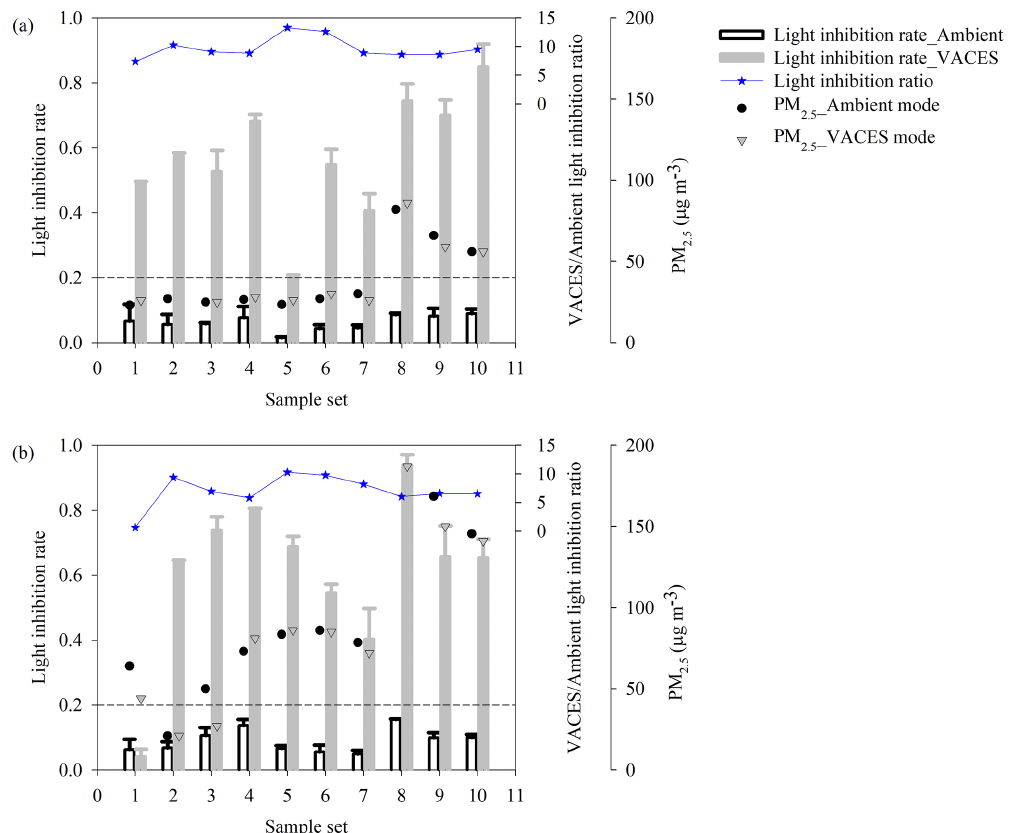
Figure 4. Comparison of light inhibition rate and ratio of ambient and VACES particles with ambient PM 2 . 5 concentration based on (a) hourly and (b) 30min discontinuous sample collection during 23 October–11 December 2019 in Shanghai, China. Baseline reflected the accuracy of photobacterium-based ecotoxicity assay method, and below the baseline, the accuracy is low.